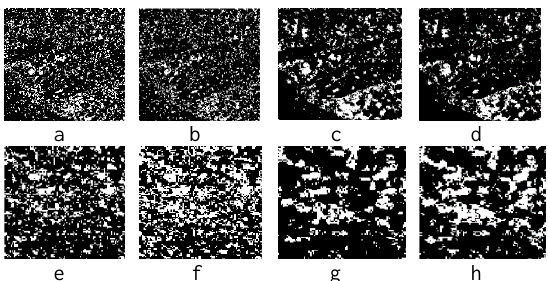
Figure 3. Output change map in KU algorithm for Data 1